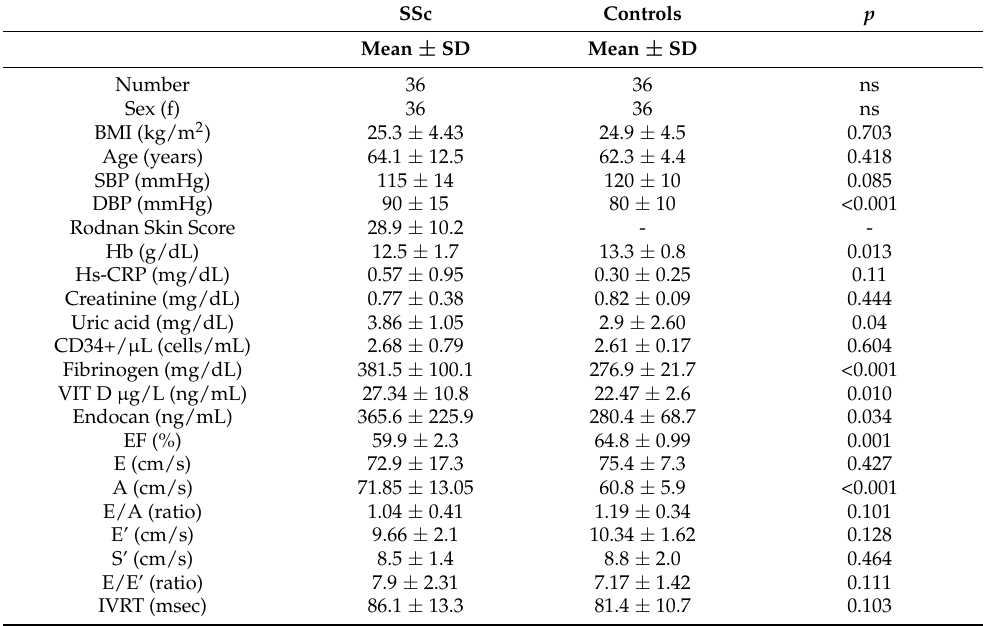
Table 1. Characteristic of the study